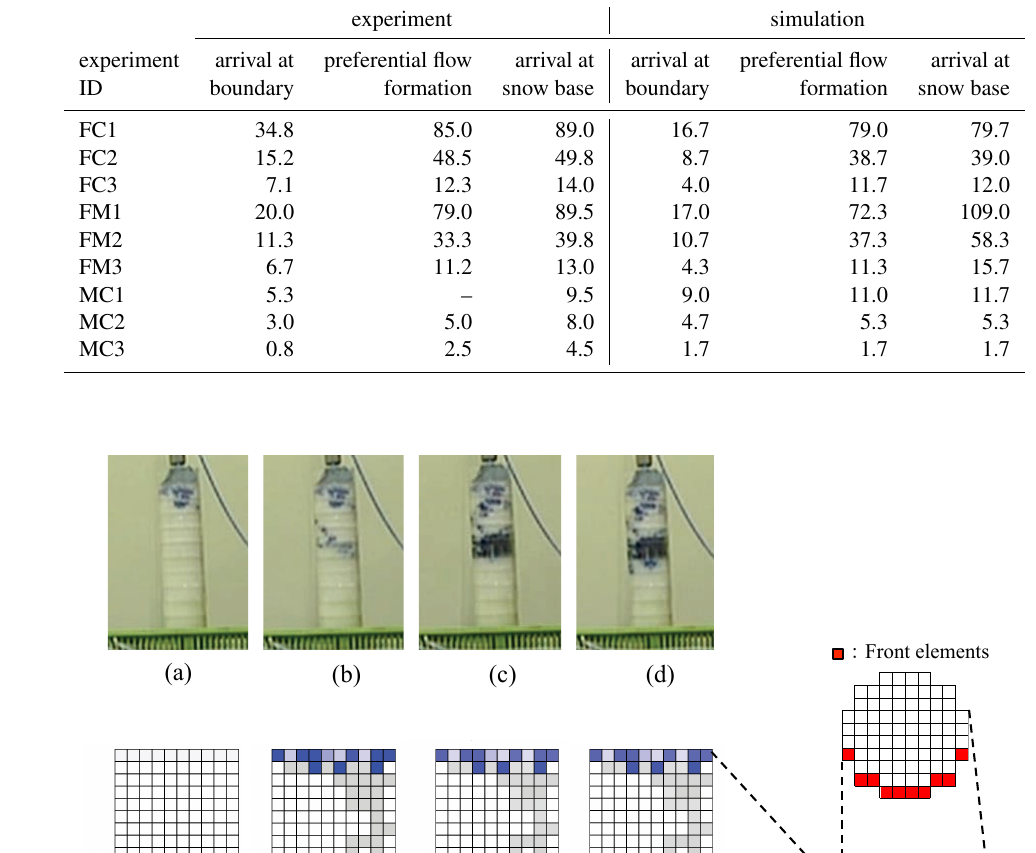
Table 2. Timings of infiltration in laboratory experiments and simulations. All the timings were estimated from the video recording of the experiment. The “–” represents points where timings could not be estimated from the video recording.